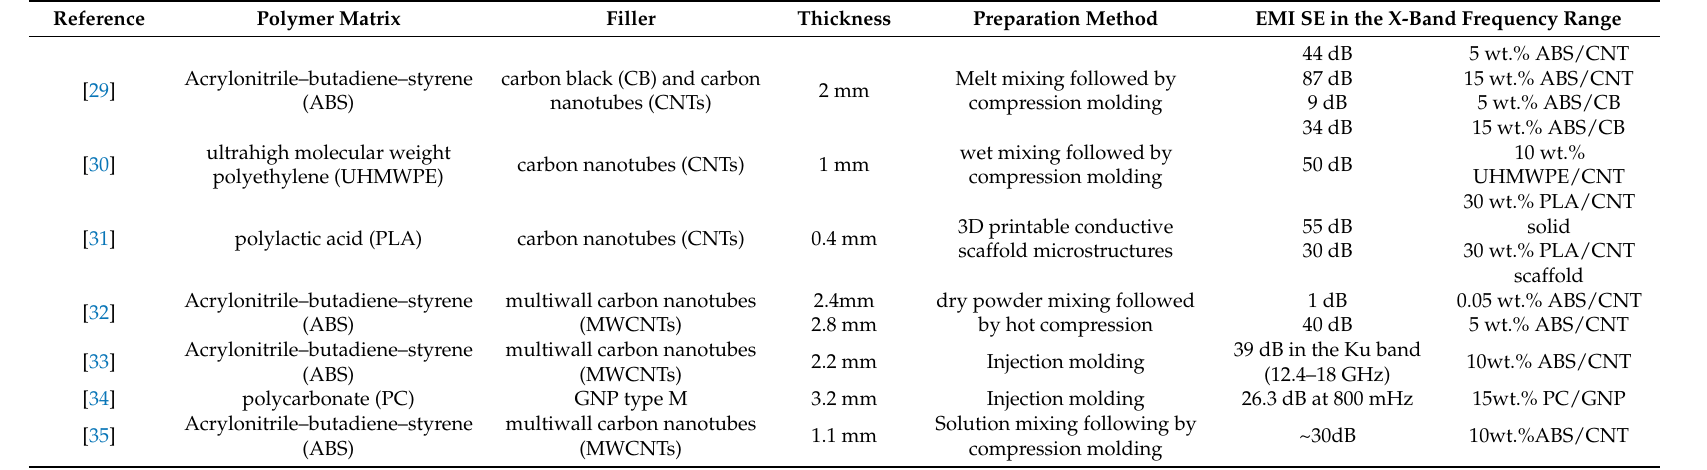
Table 3. Comparative view of EMI SE of polymer nanocomposites investigated by various